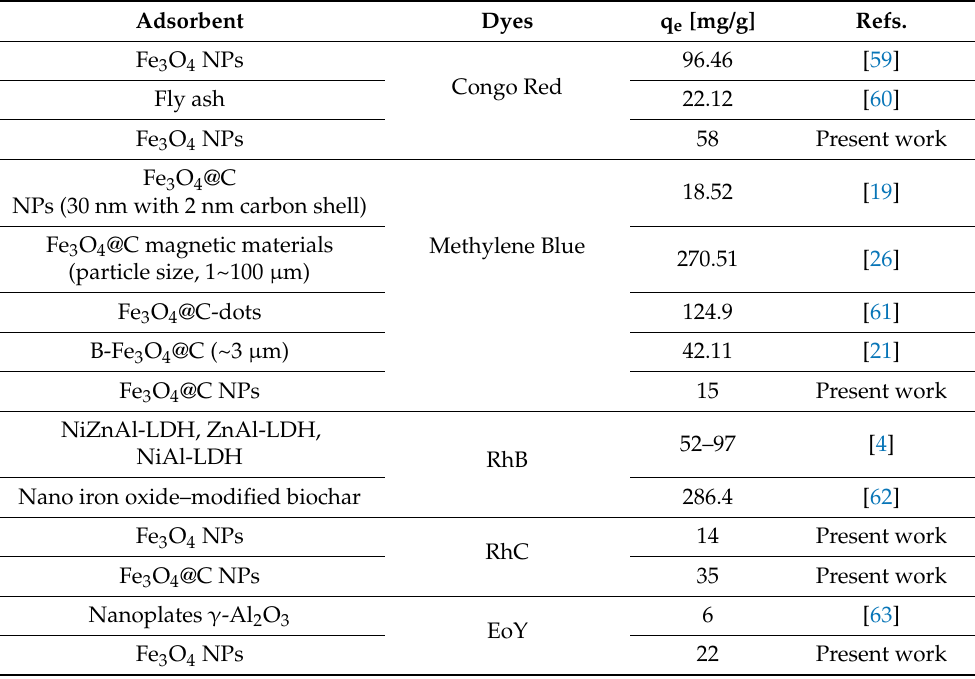
Table 4. Comparison of several dyes’ adsorption capacities reported in the literature and obtained in the present work.